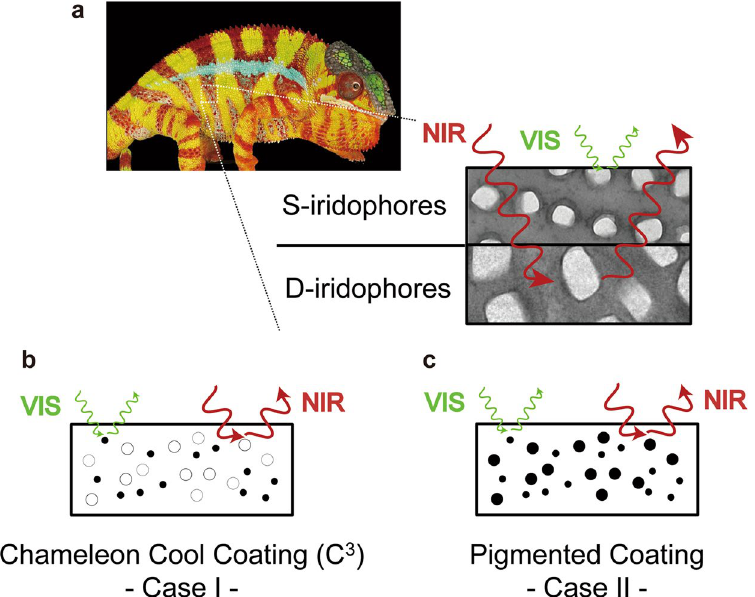
Figure 1. C 3 Concept. ( a ) Schematic of the thermal barrier in a chameleon. Picture of chameleon and transmission electron microscope image of guanine nanocrystals in superficial (S-) and deep (D-) iridophores obtained from a paper written by Teyssier et al . 4 . We acknowledge their excellent work. ( b ) Schematic of C 3 . The black particle controls the VIS light, and the white particle reflects the NIR light. ( c ) Schematic of a usual coating pigmented by a single